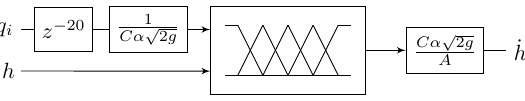
Figure 21. Input and output scaling factors. The resultant Mamdani model